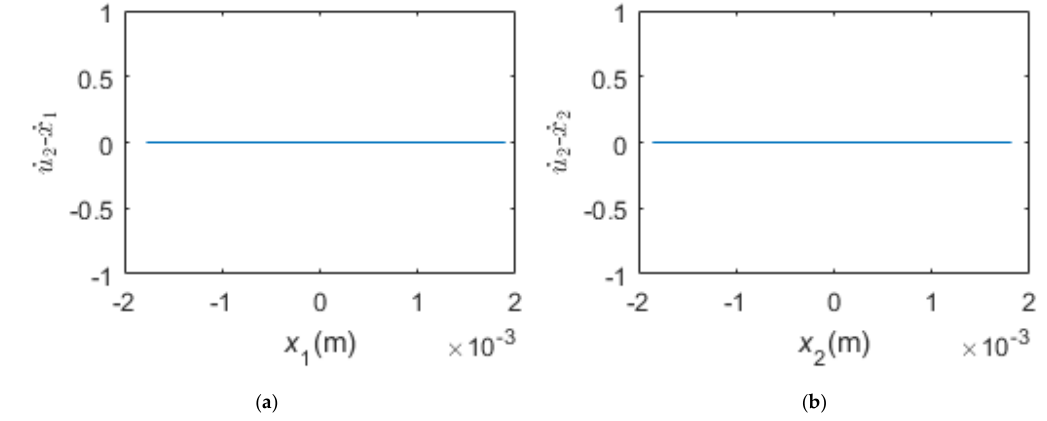
Figure 19. The relative velocity of the contact points versus displacements of the dampers, ( a ) left damper; ( b ) right damper.